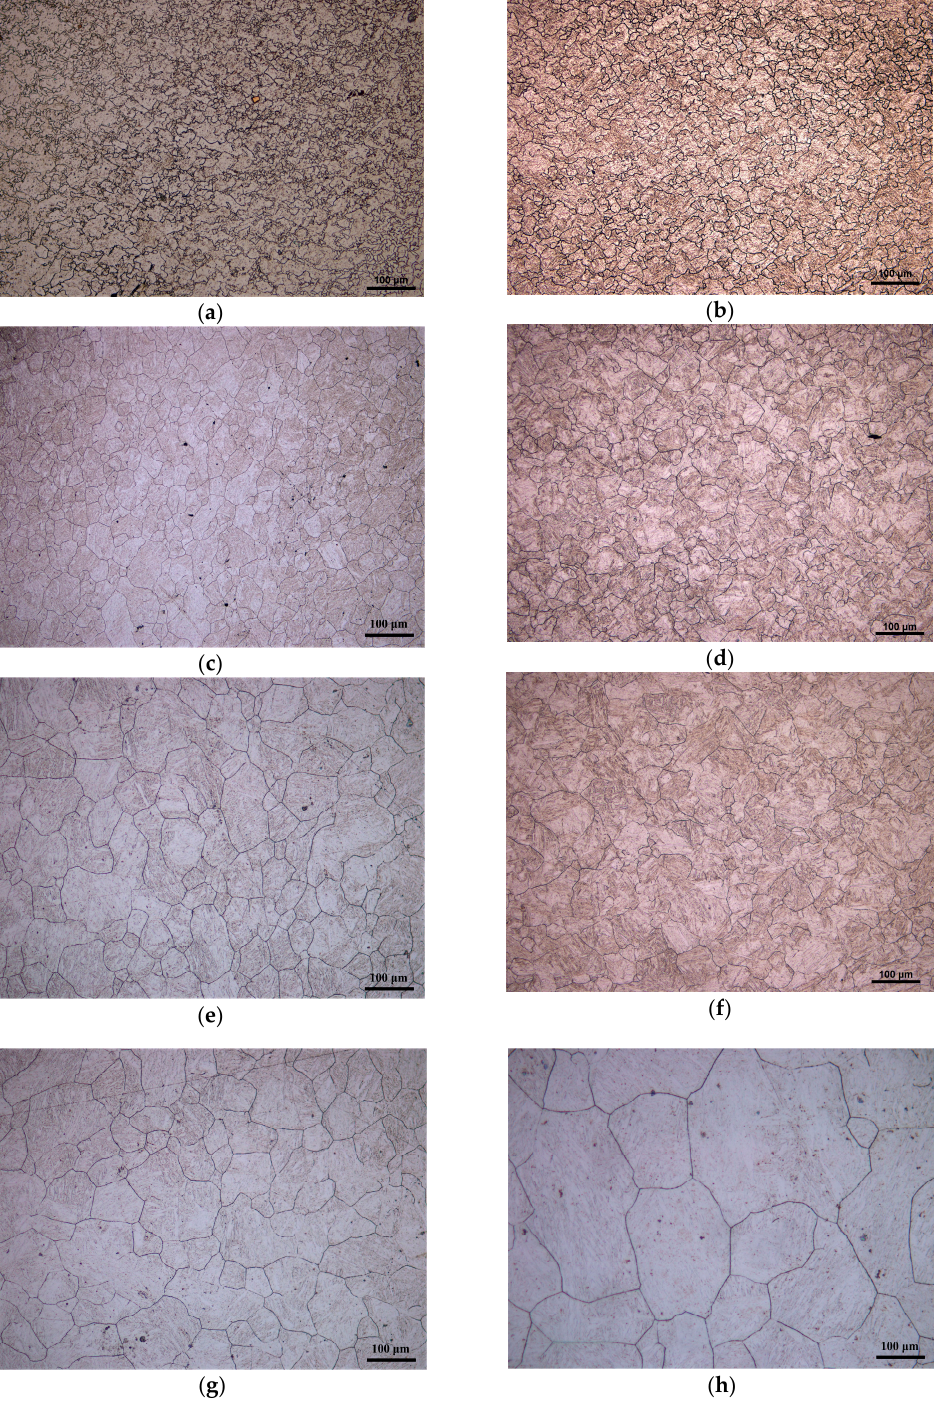
Figure 3. Microstructure of 20Mn5 steel compressed to a true strain of 0.7 under strain rate of 0.01/s and temperatures of: ( a ) 850 °C; ( b ) 900 °C; ( c ) 950 °C; ( d ) 1000 °C; ( e ) 1050 °C; ( f ) 1100 °C; ( g ) 1150 °C; ( h ) 1200 °C.